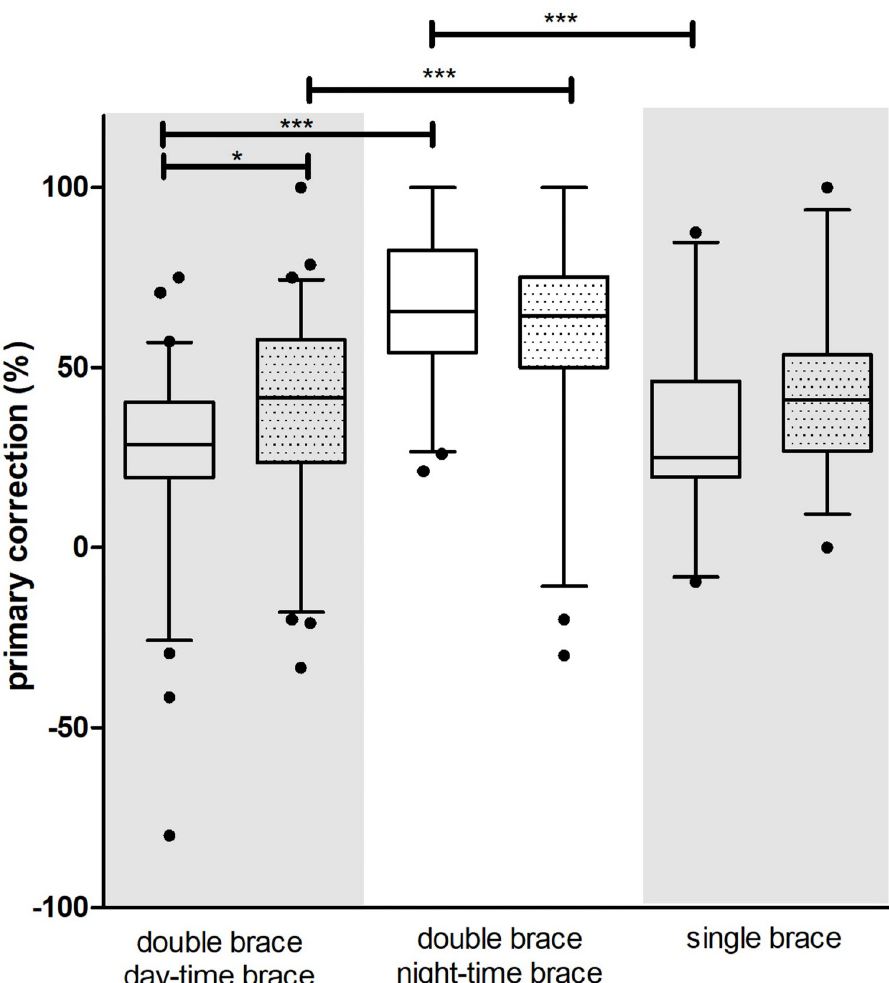
Fig 4. Primary correction (%) of brace therapy; plain boxplots thoracic spine values, dotted boxplots lumbar spine values, ��� p < 0.001, � p < 0.05, descriptive statistics can be found in the S1